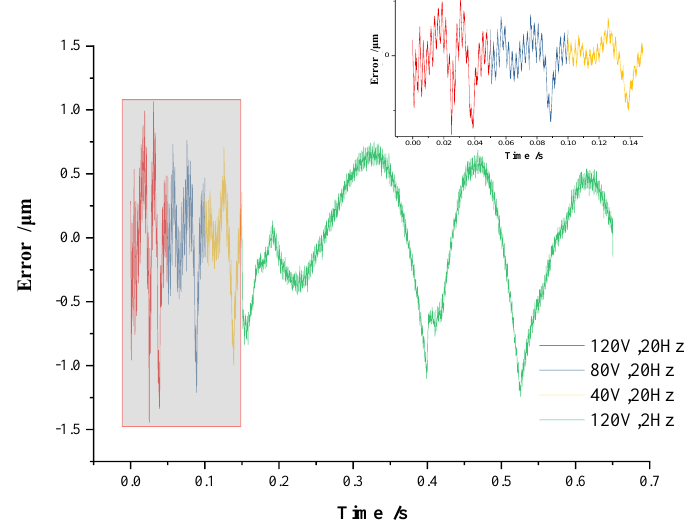
Figure 9. MPI error on variable amplitudes variable frequencies voltage.